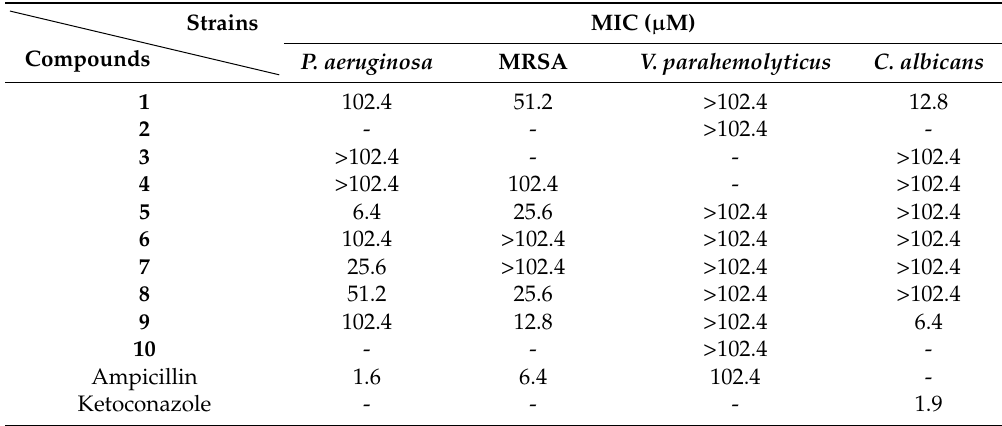
Table 3. Antimicrobial activities of compounds 1 – 10 tested by microdilution method. Strains MIC ( µ Compounds